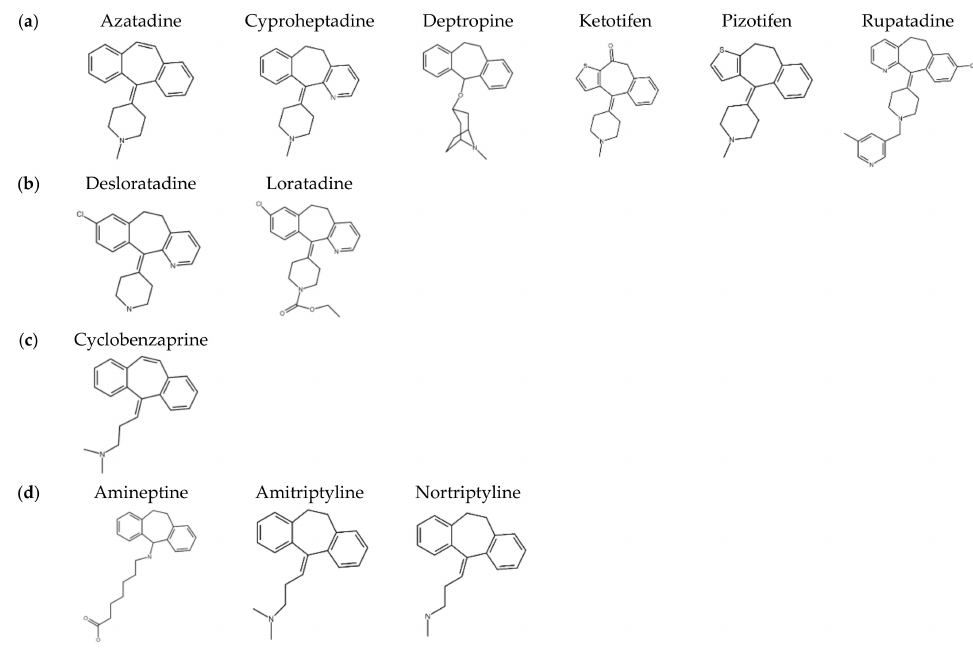
Figure 1. Structures of 12 benzocycloheptene analogous drugs. These drugs can be divided into four groups: ( a ) first-generation antihistamines, ( b ) second-generation antihistamines, ( c ) muscle relaxants, and ( d ) antidepressants and